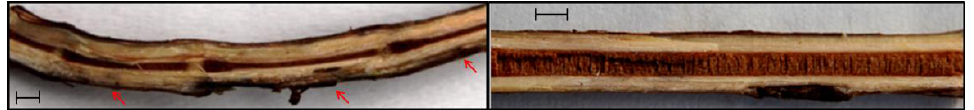
Figure 1. Brown necrosis (indicated by the red arrow) caused by N. vitifusiforme extending along a